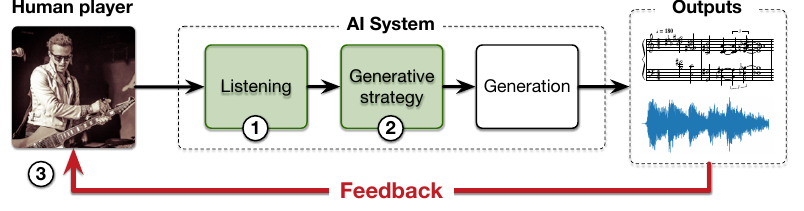
Figure 2. General scheme of an interactive co-improvisation